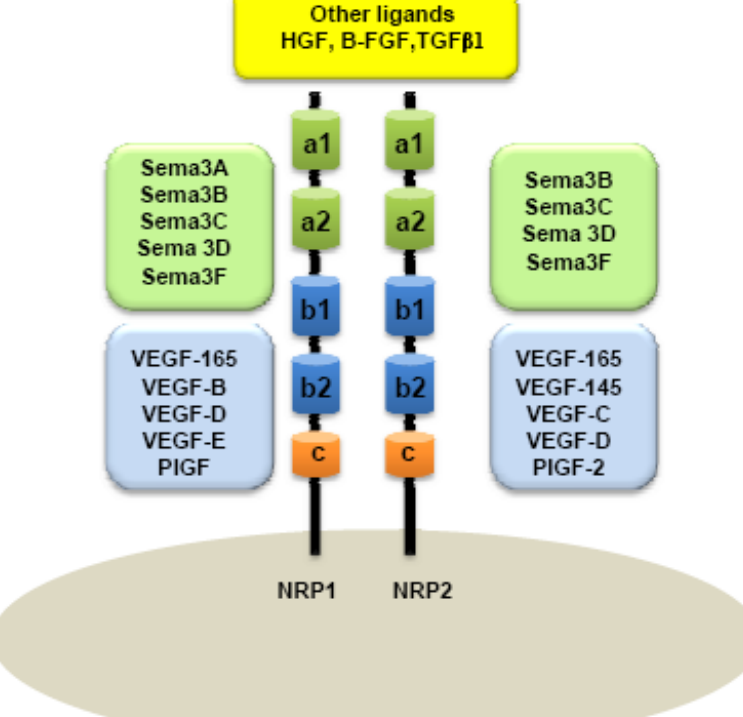
Figure 1. Neuropilins (NRPs) and their ligands. Class-3 semaphorins bind a1/a2 sub-units (green) whereas vascular-endothelial growth factors preferentially bind b1/b2 sub-units (blue). Other growth factors such as HGF, B-FGF, TGFβ1 have been recently reported to bind both NRPs